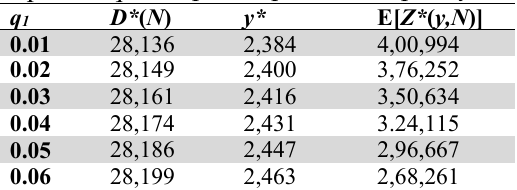
Impact of d on optimal production policy Impact of q 1 on optimal production policy